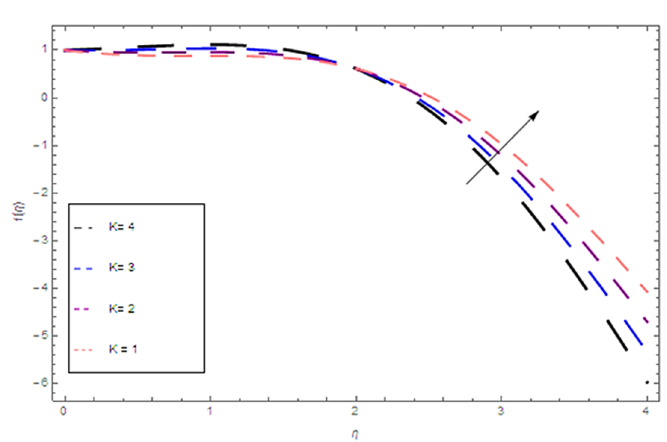
Figure 6. Effect of K on f ( η ) while M = 0.3.